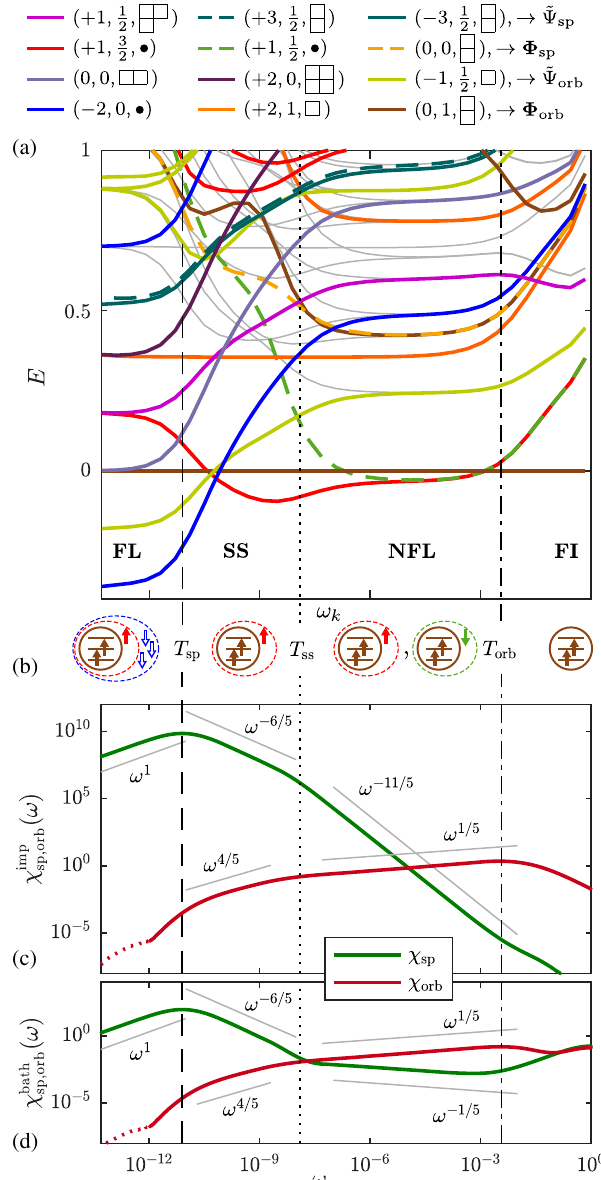
FIG. 2. NRG results for c 0 ¼ ð J 0 ; K 0 ; I 0 Þ ¼ ð 10 − 4 ; 0 . 3 ; 0 Þ . (a) Finite-size eigenlevel spectrum computed by NRG, with as reference energy. Quantum numbers Q ¼ ð q; S; λ Þ are shown at the top, and → indicates boundary operators obtained via double fusion. (NRG parameters: Λ ¼ 2 . 5 ; number 3000 ; half-bandwidth of the bath, of kept multiplets, N keep ¼ D ¼ 1 .) (b) Illustrations of the ground states encountered during the flow. (c),(d) Imaginary part of the spin and orbital suscep- tibilities of (c) the impurity and (d) the bath site coupled to it (Wilson chain site k ¼ 0 ). Gray lines show power laws predicted by CFT. Vertical lines show the crossover scales for orbital and spin screening, T and T , marking the maxima of χ imp and orb sp orb χ imp T , marking kinks in χ imp ; bath sp , and for spin splitting ss sp ; orb